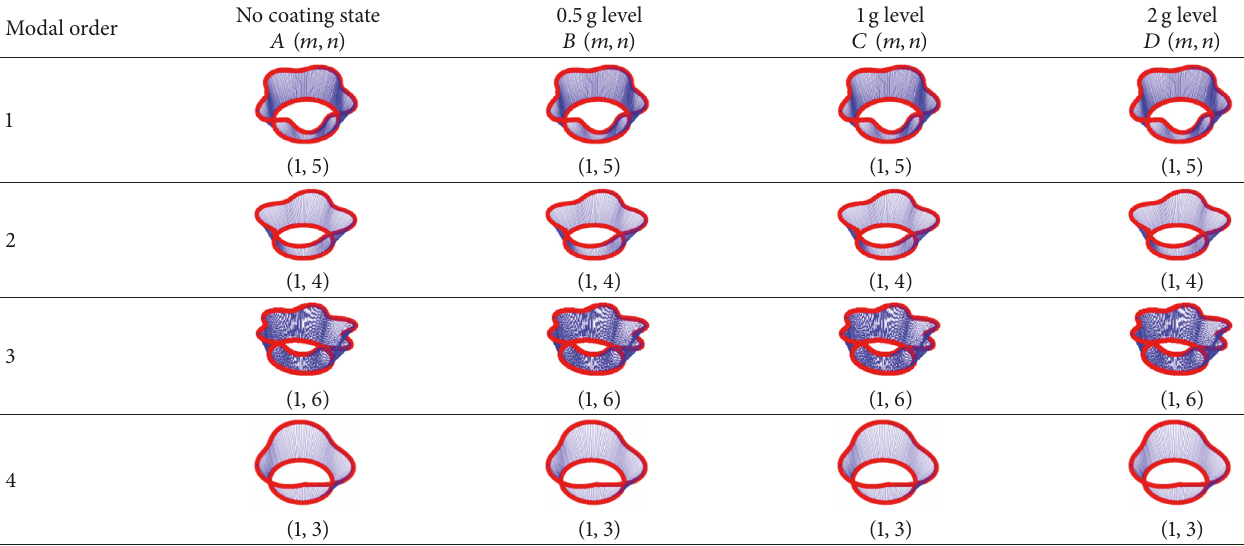
Table 10: The first 4 mode shapes of cantilever cylindrical shell coated with and without hard coating under different excitation levels. Modal order